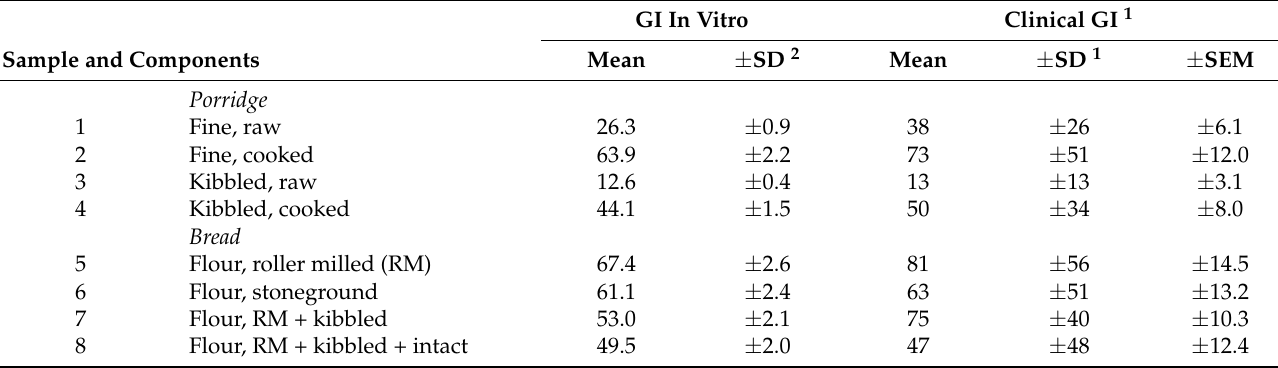
Table 3. GI values determined from incremental areas under the net GGE curves from in vitro digestion (Figures 1 and 2) compared with GI values calculated from published areas under the curves of blood glucose response to the same products. GI In Vitro Clinical GI